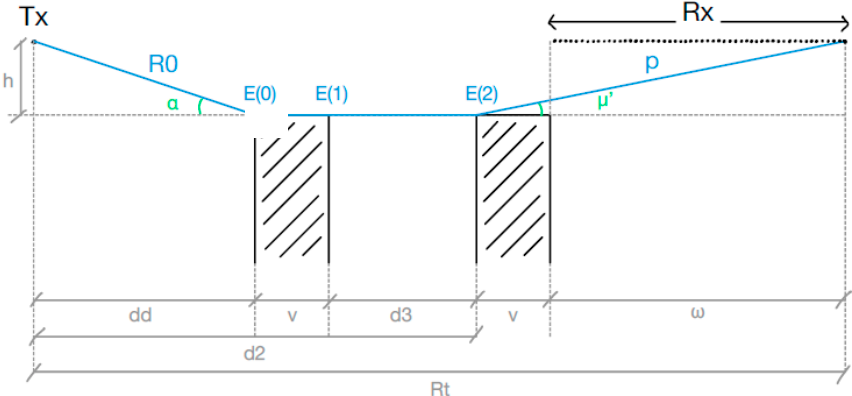
Figure 10. First triple diffraction (Edif_t1) of the considered LOS scenario.